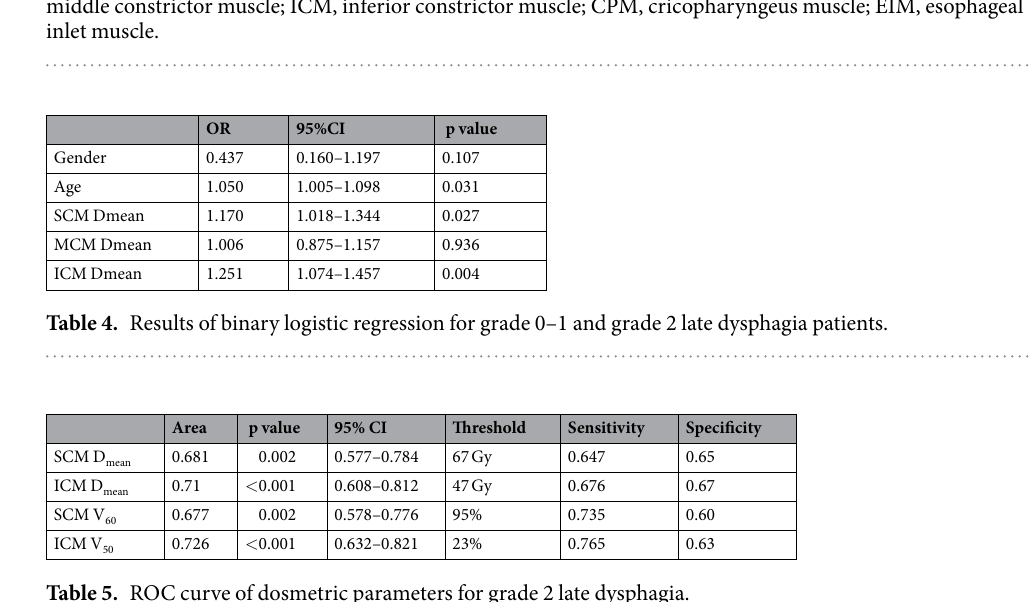
Table 5. ROC curve of dosmetric parameters for grade 2 late